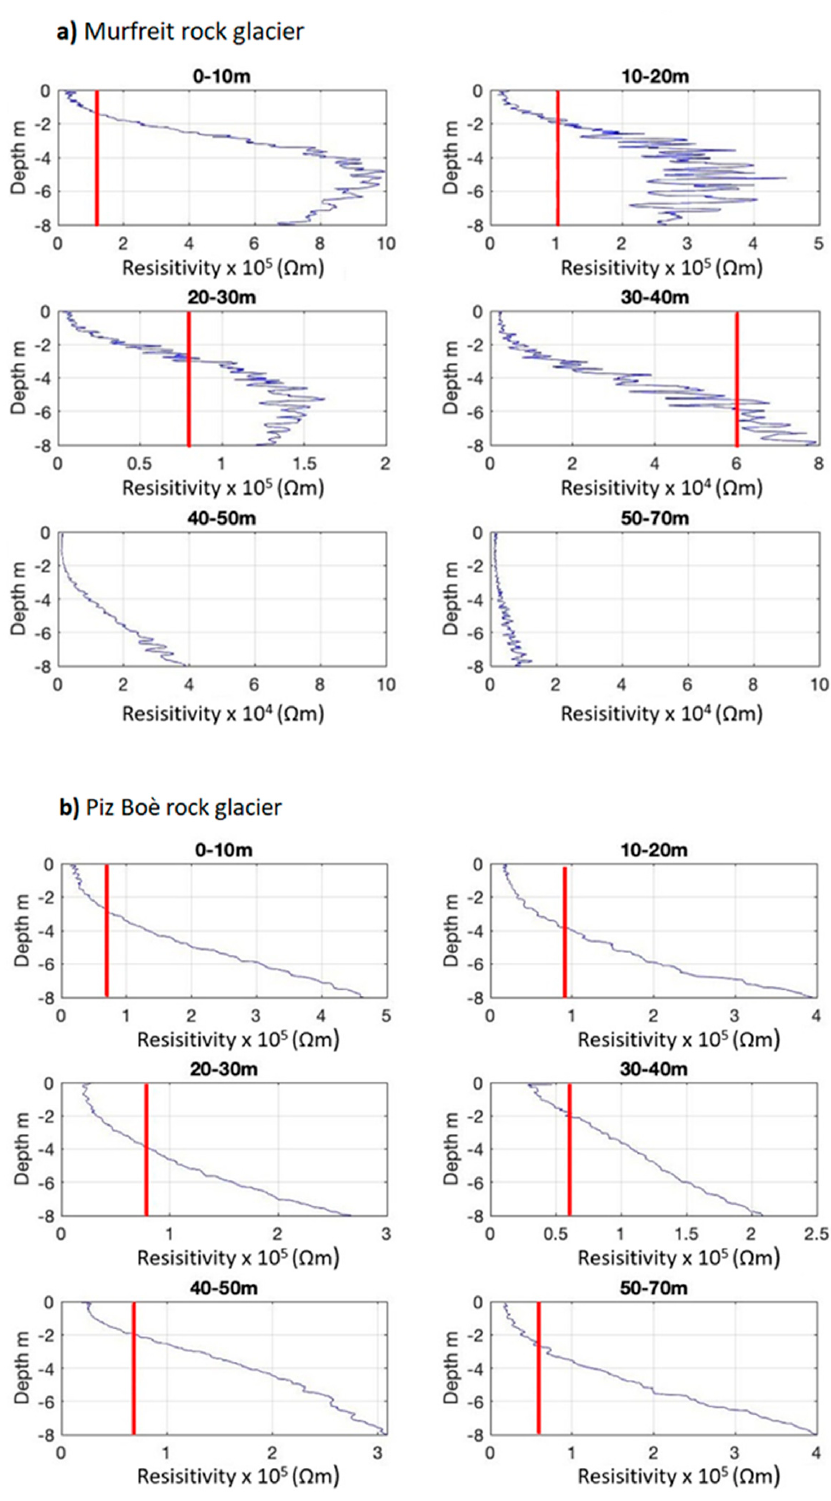
Figure 7. Steepest gradients search at ( a ) Murfreit and ( b ) Piz Boè sites. Resistivities are averaged over 10 m sections and plotted as a function of depth (blue line). The intersections with the vertical red lines are used to define the inflection points, i.e., the steepest gradient between the minimum and maximum resistivity values in the considered section. In Figure 7a, steepest gradients were not represented in the last 2 panels, since after 40 m the resistivity values are <<10 5 Ohm m, and no ice presence is expected in the first 8 m of subsoil [50].